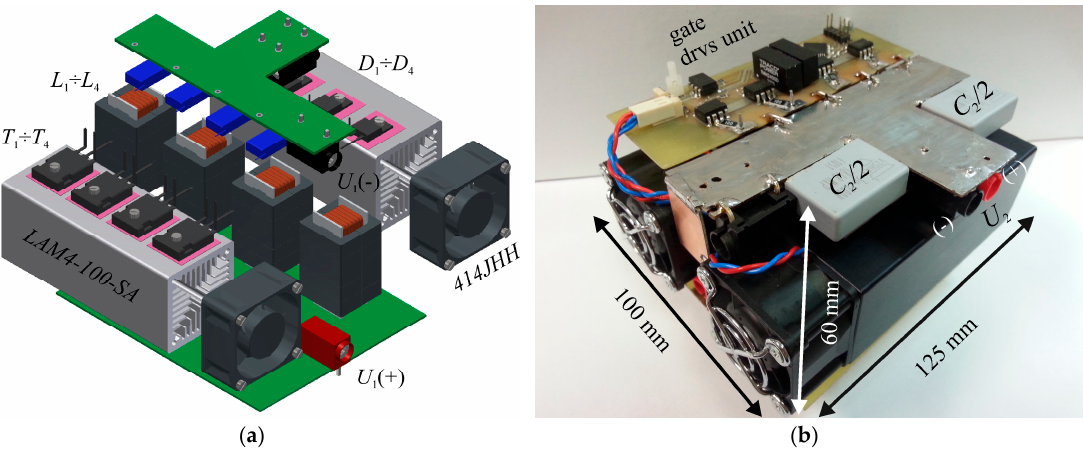
Figure 7. ( a ) A visualization and ( b ) a picture of the four-leg interleaved boost converter